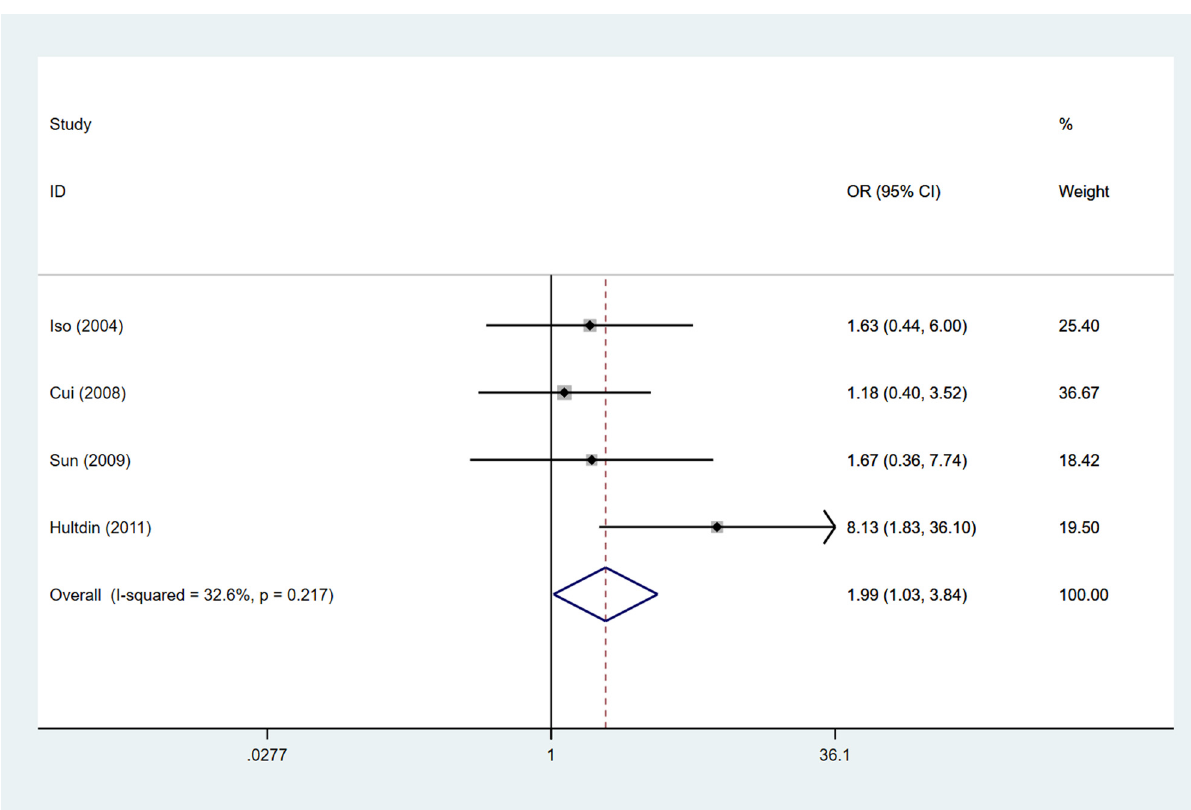
Figure 4: Forest plots showing the e ff ect of elevated Hcy levels on hemorrhagic strokes. The risk of hemorrhagic stroke was compared between the highest and lowest Hcy - level groups using a fi xed - e ff ects model, and the pooled adjusted OR was